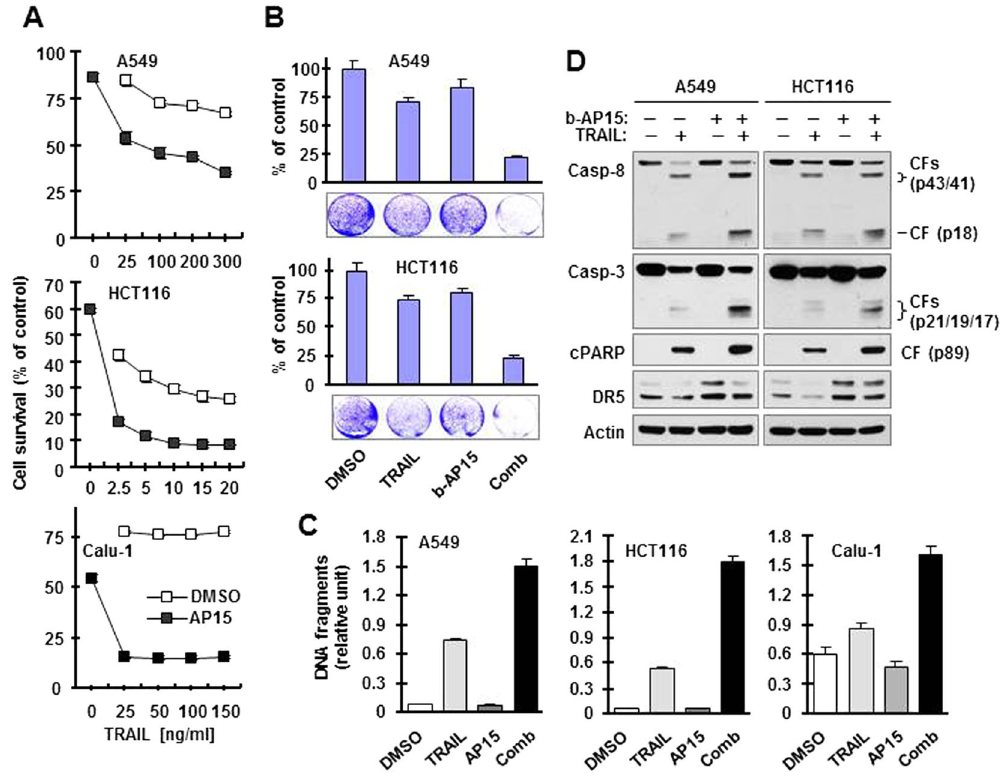
Figure 3. b-AP15 enhances the effects of TRAIL in decreasing cell survival ( A and B ) and inducing apoptosis ( C and D ) in cancer cells. ( A ) Different cancer cell lines in 96-well plates were exposed to DMSO or 0.5 μ M b-AP15 for 3 h followed by co-treatment with varied concentrations of TRAIL for an additional 24 h. Cell numbers were the estimated with the SRB assay. The data are means ± SDs of four replicate determinations. ( B ) The given cell lines in 12-well plates were pre-treated with DMSO or 0.1 μ M b-AP15 for 4 h and then co-treated with 50 ng/ml (A549) or 5 ng/ml (HCT116) TRAIL for an additional 60 h. The cells were then stained with crystal violet dye. The data are means ± SDs of triplicate determinations. ( C and D ) The indicated cell lines were exposed to 0.5 μ M b-AP15 for 3 h followed by co-treatment with 100 ng/ml (A549 and Calu-1) or 10 ng/ml (HCT116) TRAIL for an additional 4 h. The cells were then harvested to measure DNA fragments with a cell death detection ELISA kit ( C ) and to detect the cleavage of caspases and PARP ( D ). The data are means ± SDs of triplicate determinations. CF, cleaved fragment. Full-length blots/gels are presented in Supplementary Figure